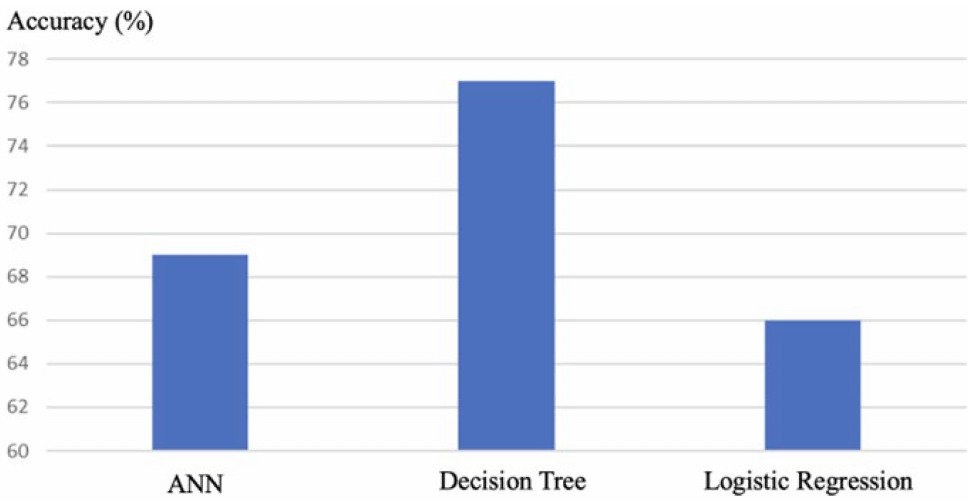
Figure 9. Comparison of algorithm